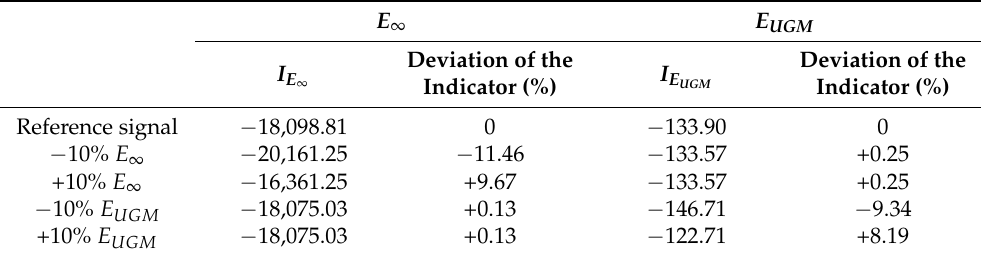
Table 3. Values and relative deviations between the different